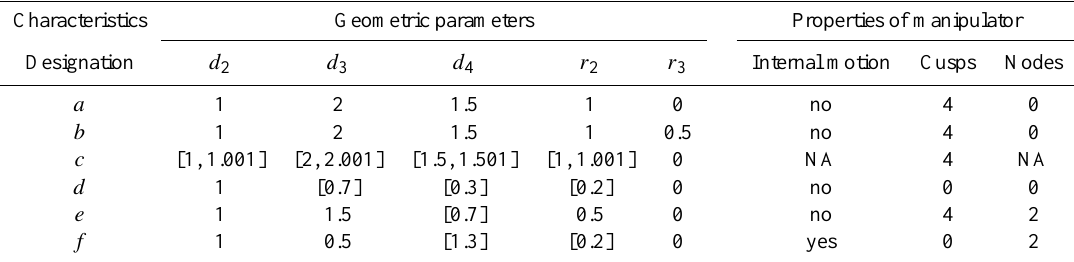
Table 1. Some studied cases of robotic manipulators. Characteristics